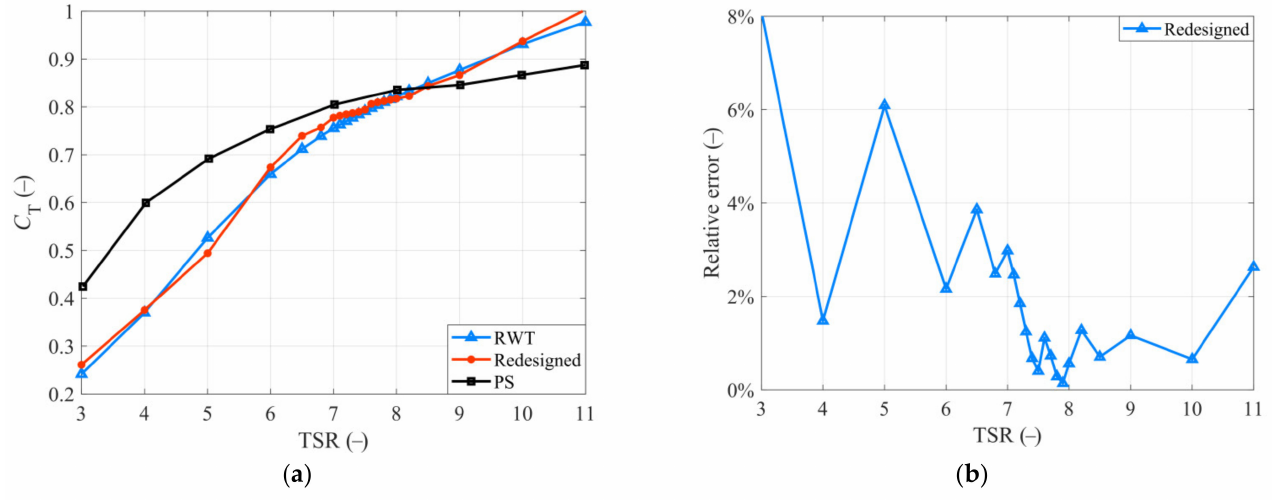
Figure 7. ( a ) The thrust coefficient comparison of redesigned blade, RWT blade and PS blade. ( b ) The relative error of redesigned blade to RWT